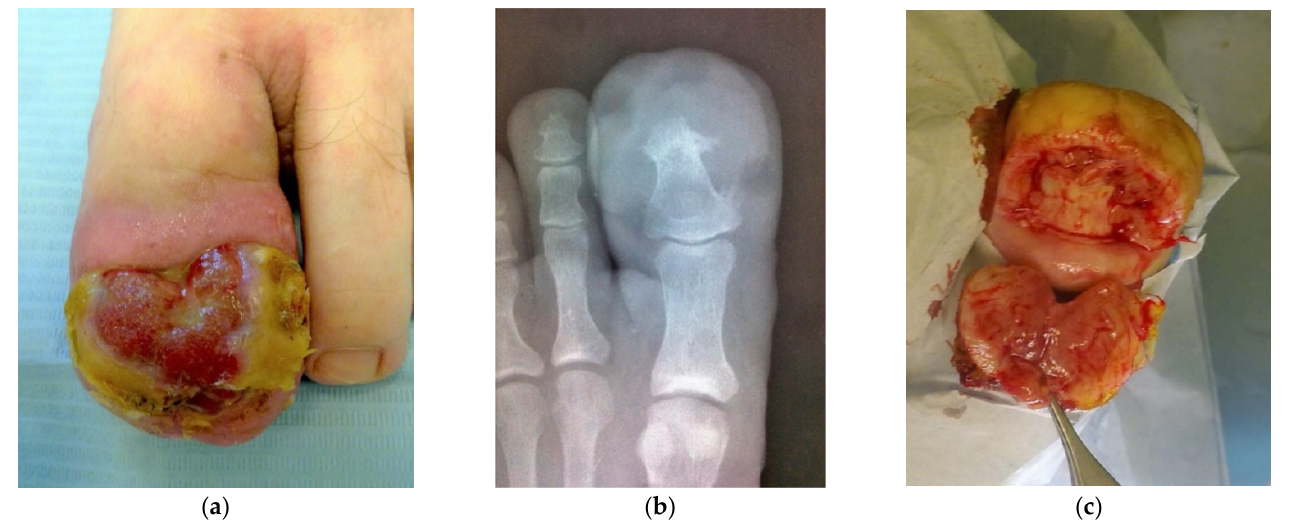
Figure 1. Ulcerated cutaneous lesion covering the nail plate ( a ). Radiographic image shows periosteal changes with the presence of osteophytes in the distal phalanx ( b ). Excisional biopsy shows polypoidaspect of lesion ( c ).